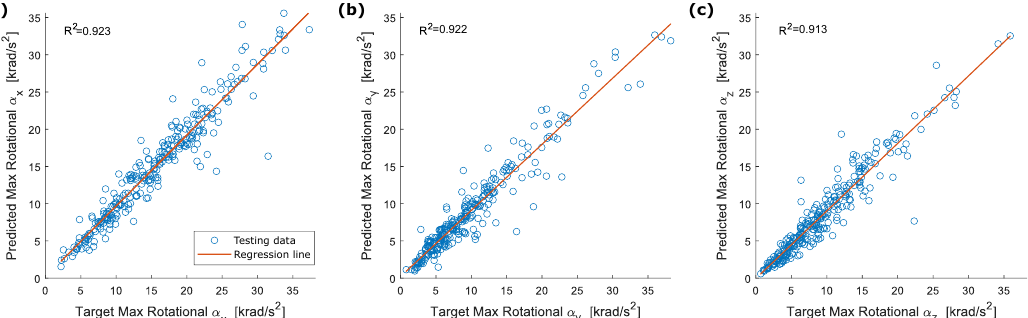
Figure 11. Correlation between target and predicted peak rotational acceleration for the reduced testing dataset (exclusion of impacts with peak rotational acceleration above 40 krad/s 2 ): ( a ) α x ; ( b ) α y ; ( c ) α z .